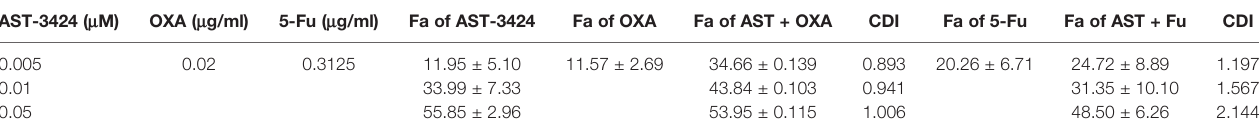
TABLE 1 | Fraction affected level (Fa) of AST-3424, OXA, and 5-Fu alone or in combination and CDI values of the combination in HepG2 cells. AST-3424 ( m